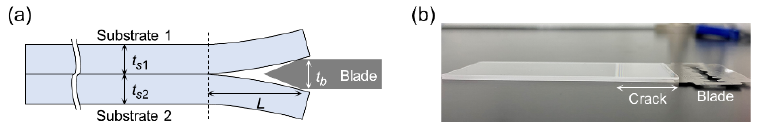
Figure 2. ( a ) Principle of crack-opening test and ( b ) photograph of bonded glass substrates with a blade inserted into the bonding